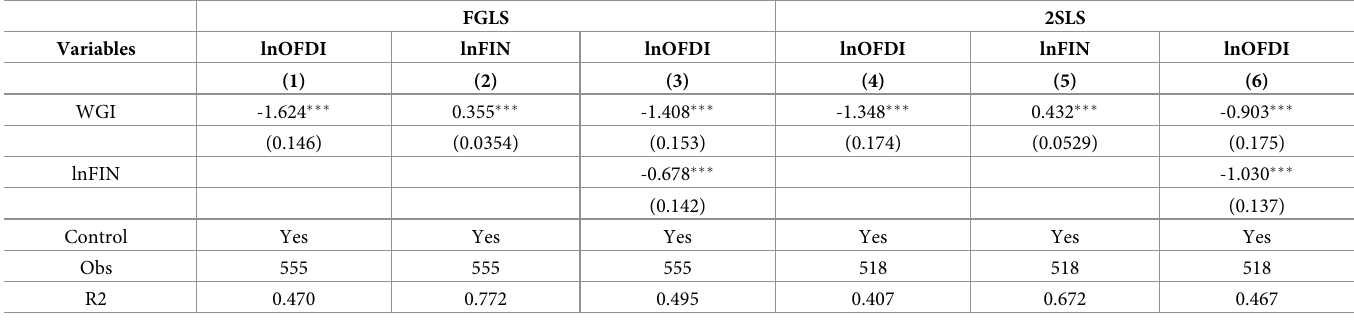
Table 5. Mechanism test estimation